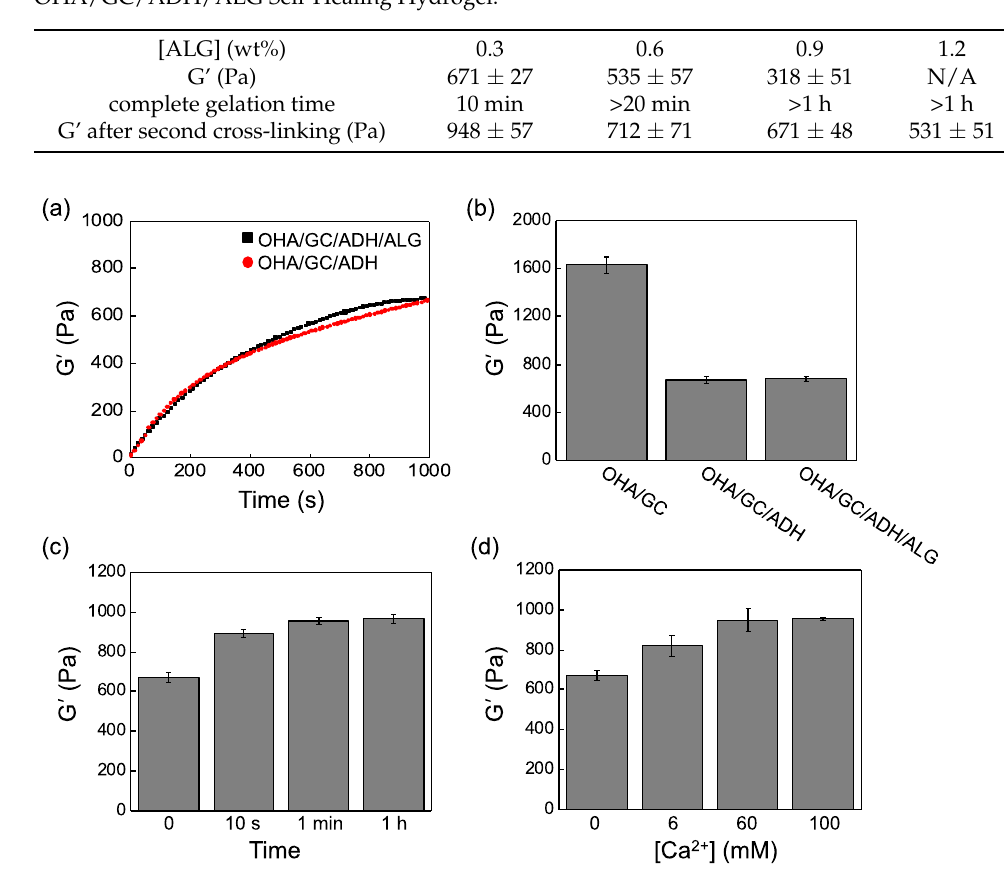
Figure 2. ( a ) Gelation kinetics of OHA/GC/ADH hydrogels prepared in the presence of ALG (black squares) and in the absence of ALG (red circles). ( b ) Storage shear moduli of OHA/GC, OHA/GC/ADH, and OHA/GC/ADH/ALG hydrogels ([OHA] = 2 wt%, [GC] = 1 wt%, [ADH] = 0.3 wt%, [ALG] = 0.3 wt%). Storage shear moduli of OHA/GC/ADH/ALG hydrogels prepared with various ( c ) second cross-linking times ([Ca 2+ ] = 60 mM) and ( d ) calcium chloride concentrations (cross-linking time = 1